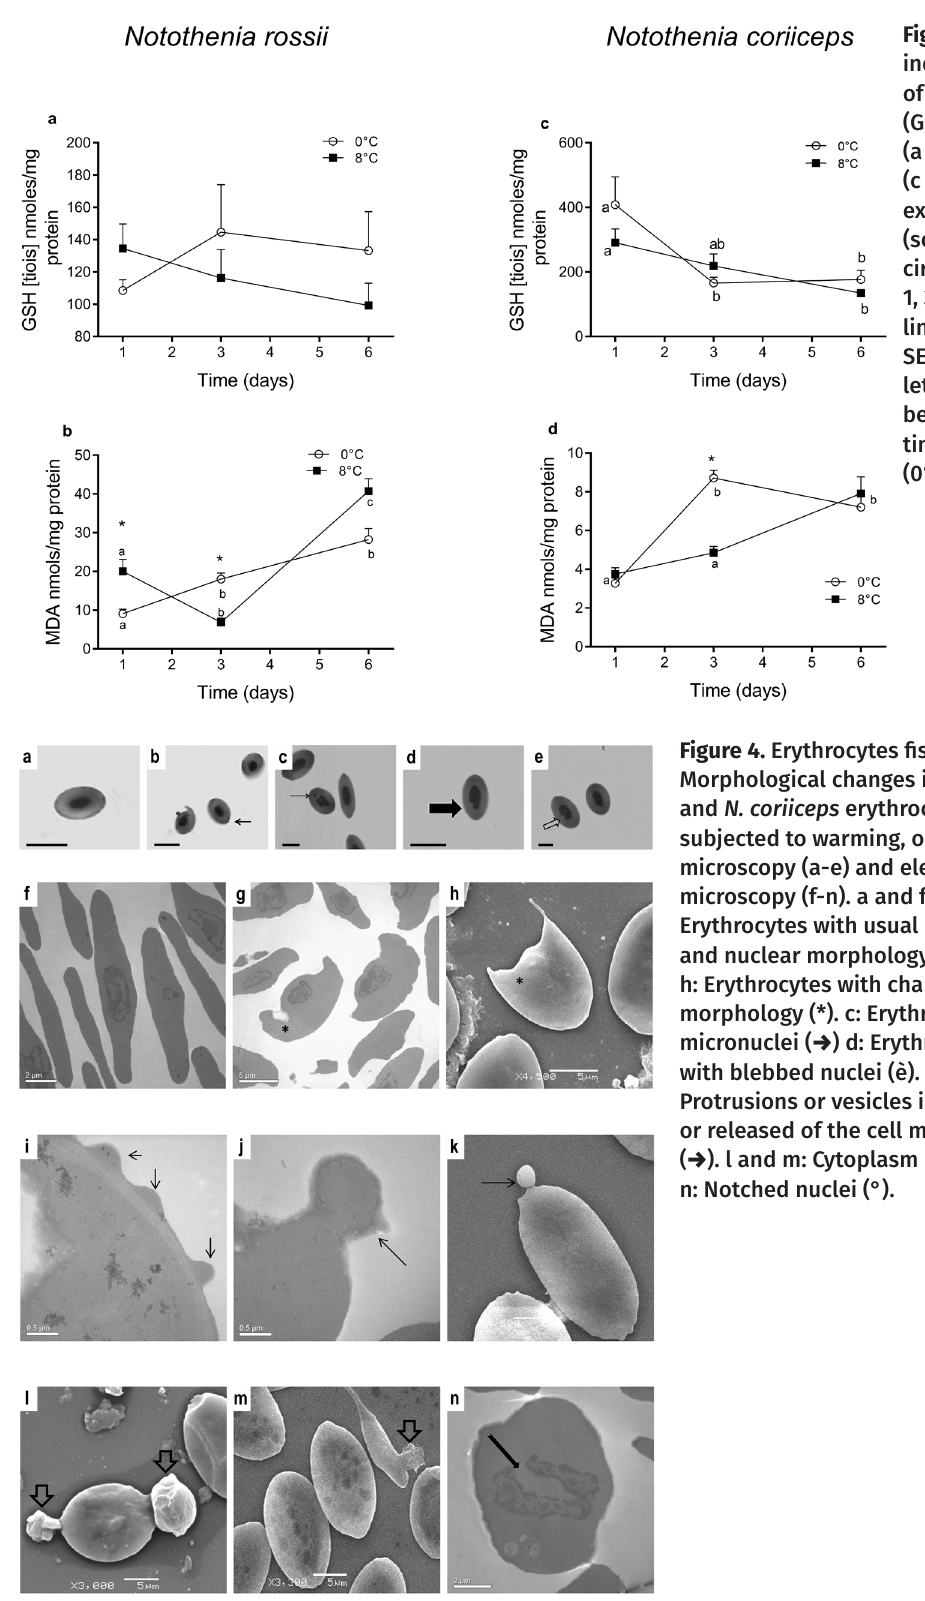
Figure 3. Oxidative stress indices. Concentration of reduced glutathione (GSH) and (MDA). N. rossii